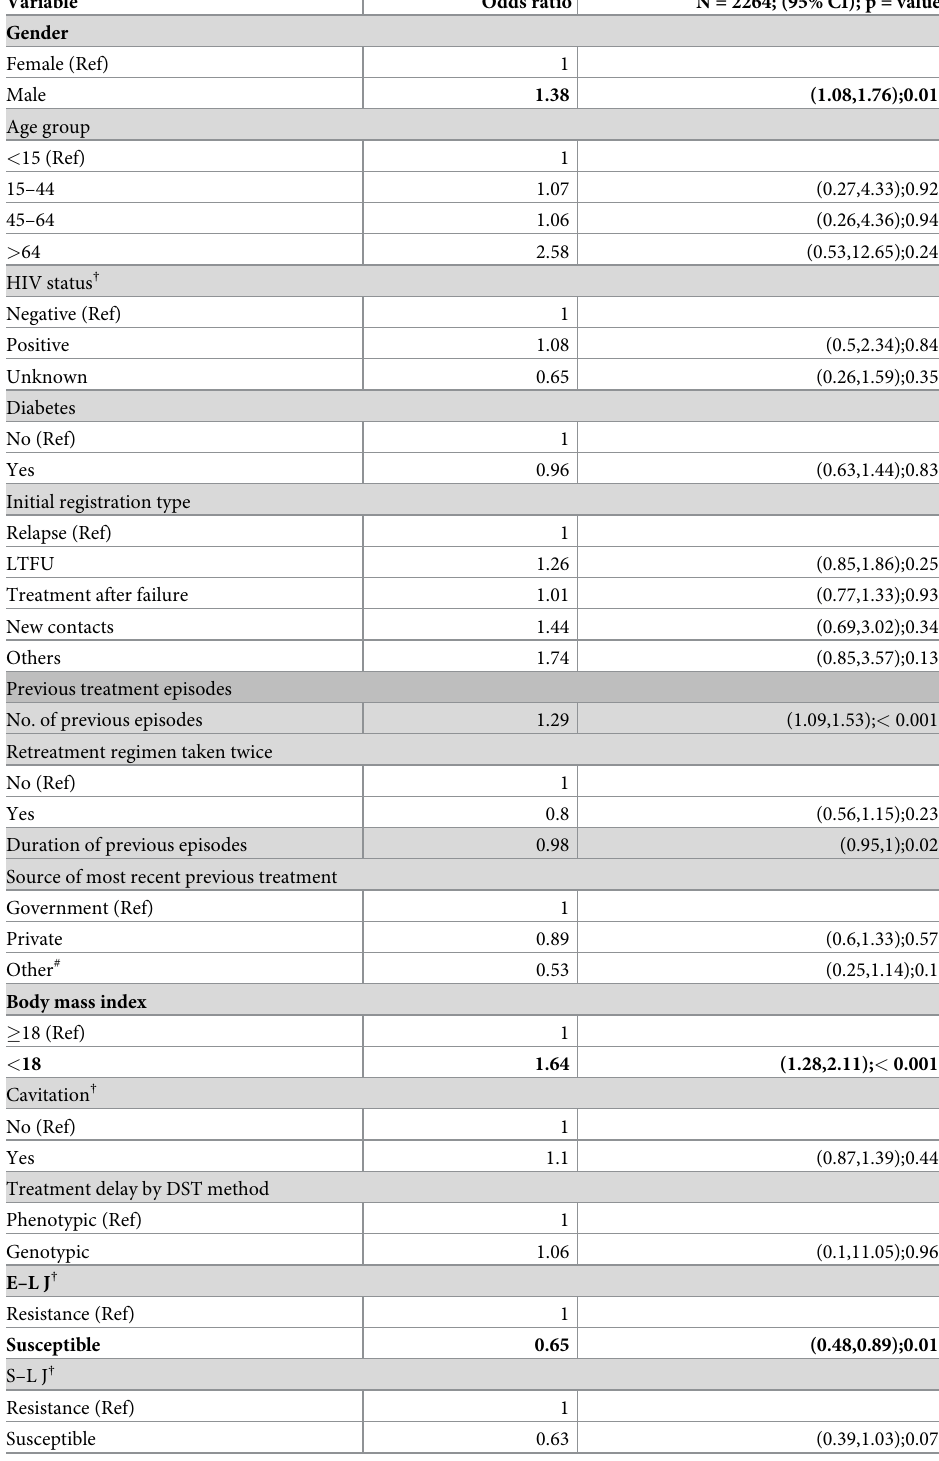
Table 4. Factors significantly associated with unfavorable treatment outcomes from logistic regression analysis. (Note: OR > 1 indicates higher odds of unfavorable outcome).